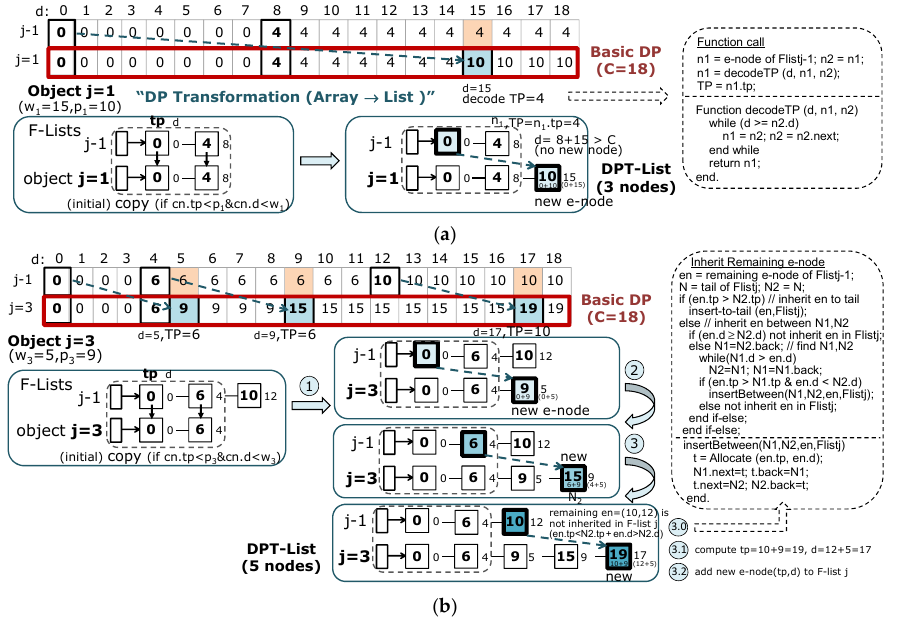
Figure 16. An example of the correct F-list j construction ( n = 5 in Figure 5): ( a ) F-list j = 1 (add a new e-node to tail of F-list j ) and ( b ) F-list j = 3 (add each of three new e-nodes to tail of F-list j ).